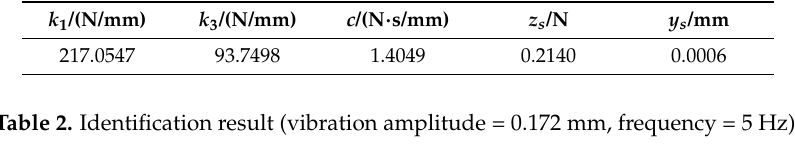
Table 1. Identification result (vibration amplitude = 0.125 mm, frequency = 5 Hz).